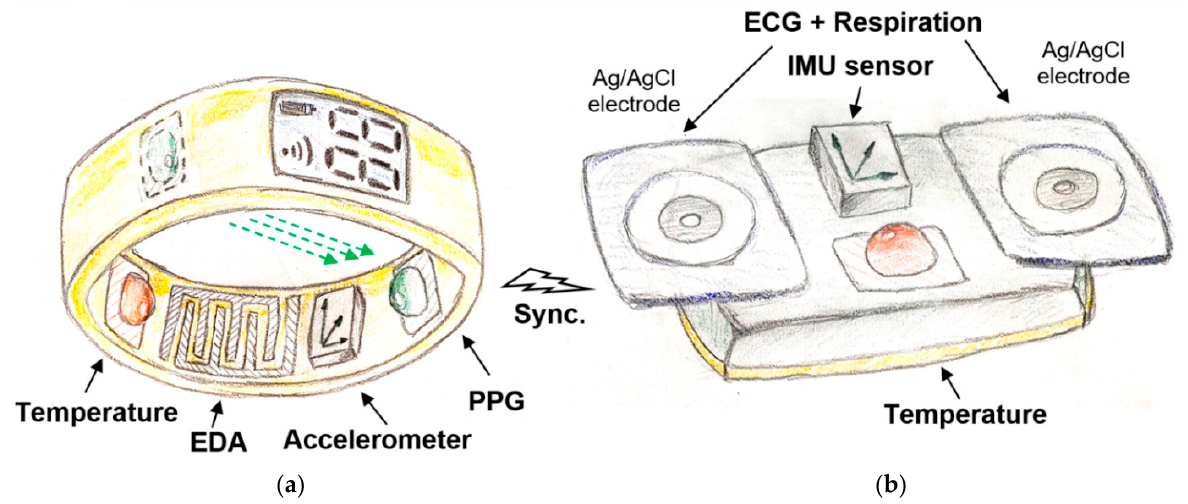
Figure 7. Concept of new stress-meter: ( a ) smart ring, ( b ) chest